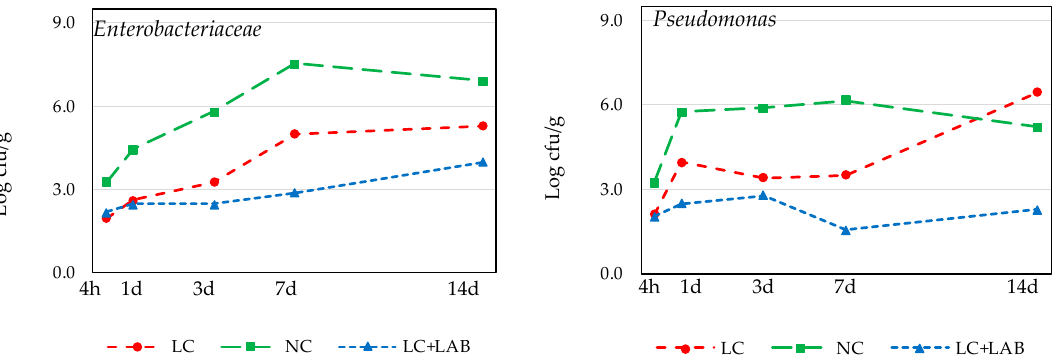
Figure 5. Counts of Enterobacteriaceae and Pseudomonas during incubation of chouriço batter made from low contaminated meat ( LC ), normal contaminated meat ( NC ), and low contaminated meat with LAB.